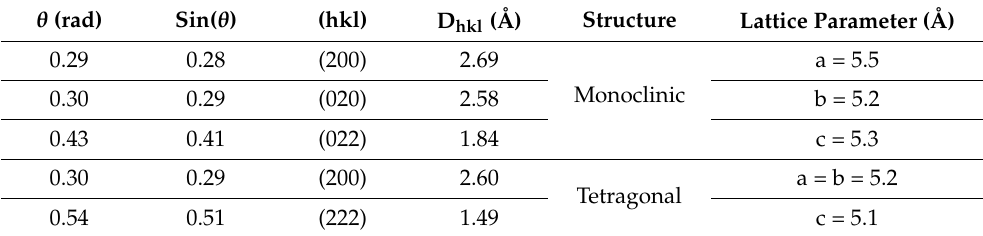
Table 2. The parameters of the monoclinic and tetragonal lattices of ZrO 2 NTs.